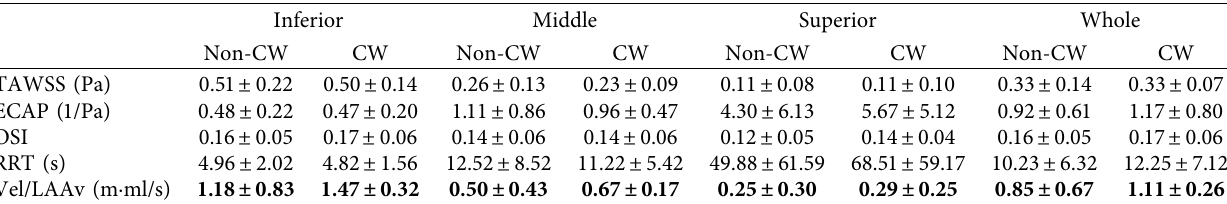
OSI CW � chicken-wing; ECAP � endothelial cell activation potential; LAAv � left atrial appendage volume; OSI � oscillatory shear index; RRT � relative resident time; TAWSS � time average wall shear stress; TIA � transient ischemic attack; Vel � velocity. Results with statistical differences are in bold. Higher values of ECAP, OSI and RRT as well as lower values of TAWSS and Vel/LAAv indicate a higher risk of thrombus formation.